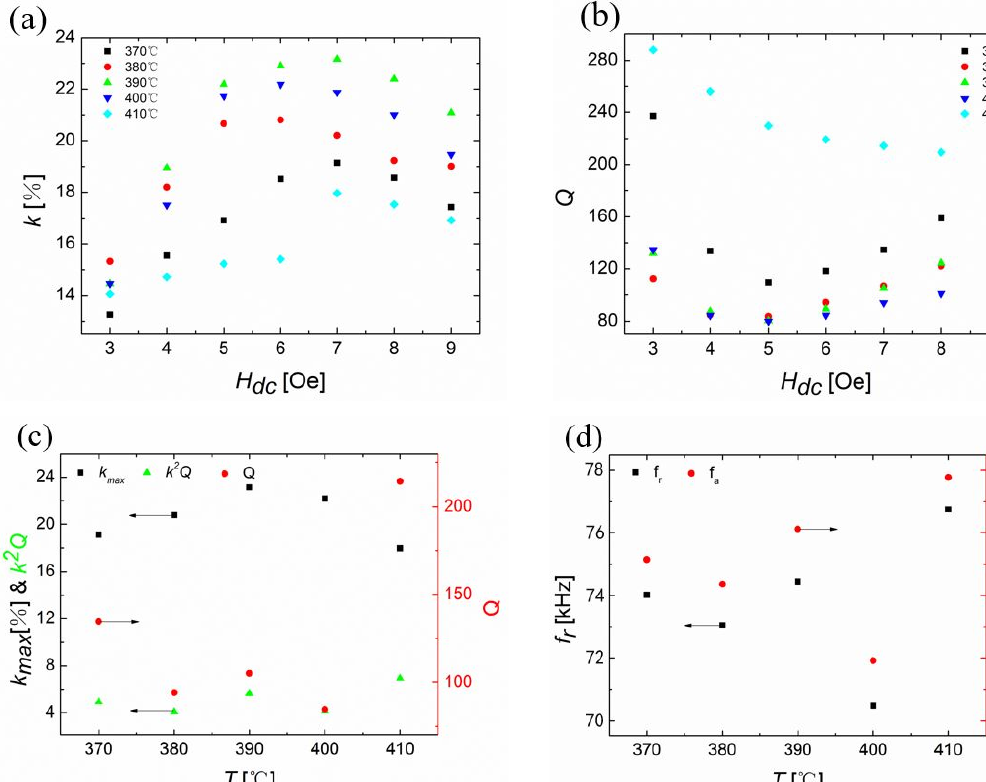
Figure 2. ( a ) The average value of the magnetomechanical coupling coefficient, kmean, for Vitrovac ribbons as a function of the bias field, H dc . Black, red, green, blue, and cyan curves represent the data for the ribbons annealed at 370 °C, 380 °C, 390 °C, 400 °C, and 410 °C for 20 min, respectively. ( b ) The average value of the quality factor, Q, of Vitrovac ribbons as a function of H dc . ( c ) The maximum values of coupling factors vs. H dc and the associated quality factors, efficiency figures of merit, k 2 Q, as a function of the annealing temperature, T. ( d ) The resonance frequencies, f r , and anti-resonant frequencies, f a , associated with the maximum coupling factors, as a function of the annealing temperature.